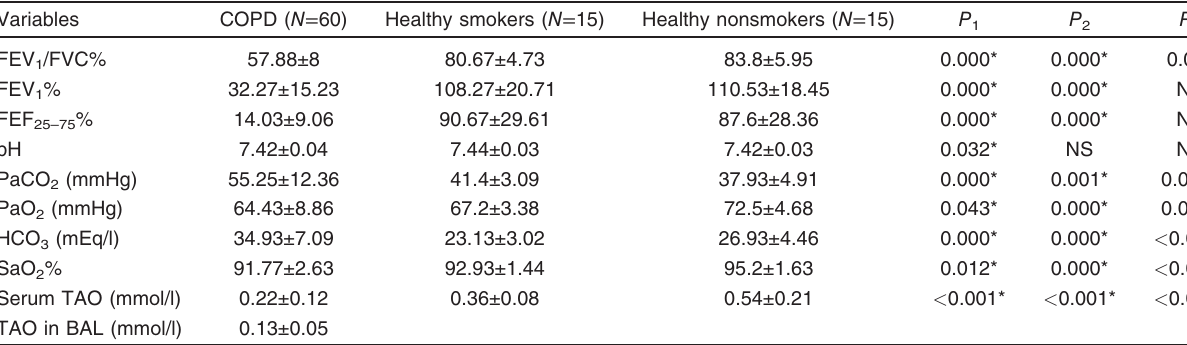
Data are expresses as mean±SD or n (%). COPD, chronic obstructive pulmonary disease. *Significant. Table 2 Functional and laboratory data of chronic obstructive pulmonary disease patients and controls